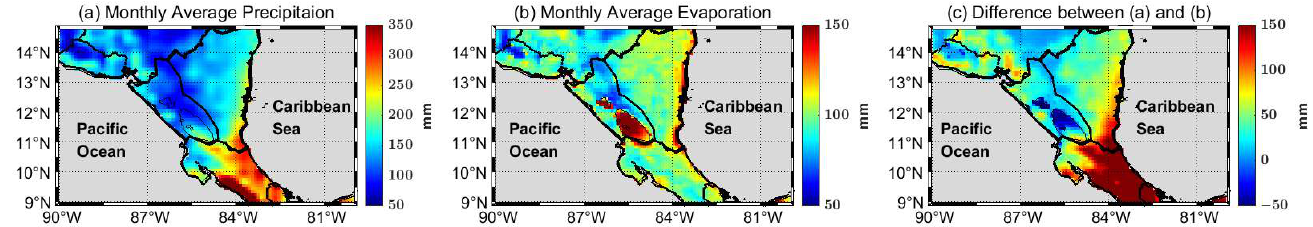
Figure 2. The monthly average spatial values in precipitation ( a ), evaporation ( b ), and the difference ( c ) between precipitation and evaporation from April 2002 to April 2021.